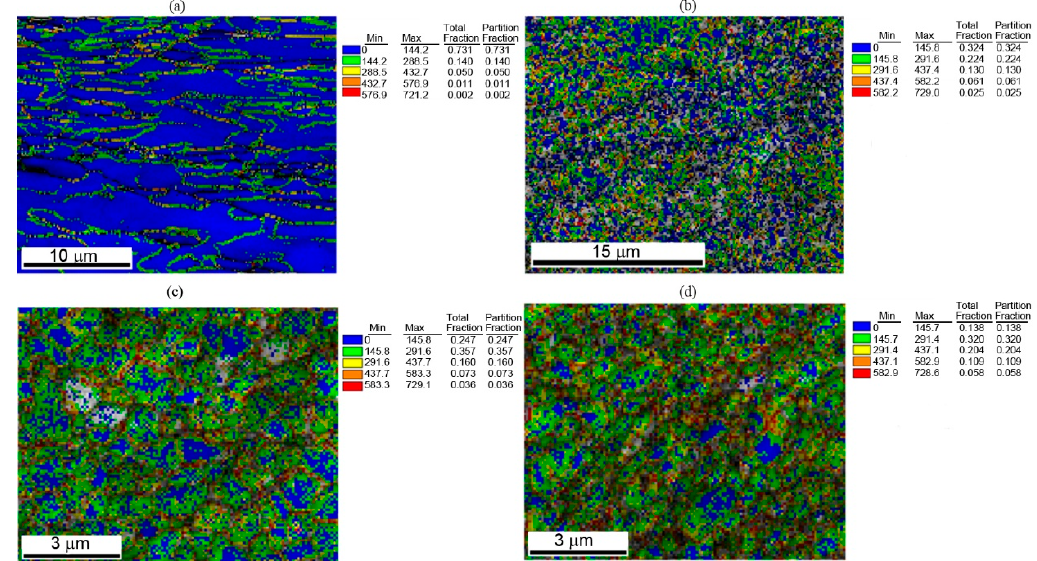
Figure 4. Geometrically necessary dislocations’ distribution maps in IF ( a,c ) and HSLA ( b,d ) steel specimens deformed with total strains of 5 ( a,b ) and 20 ( c,d ).